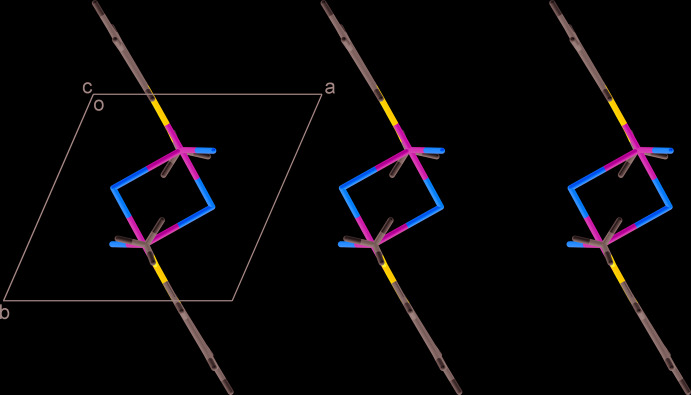
Fragment of crystal packing of [CuLCl2]2 (I) viewed along the c-axis direction.